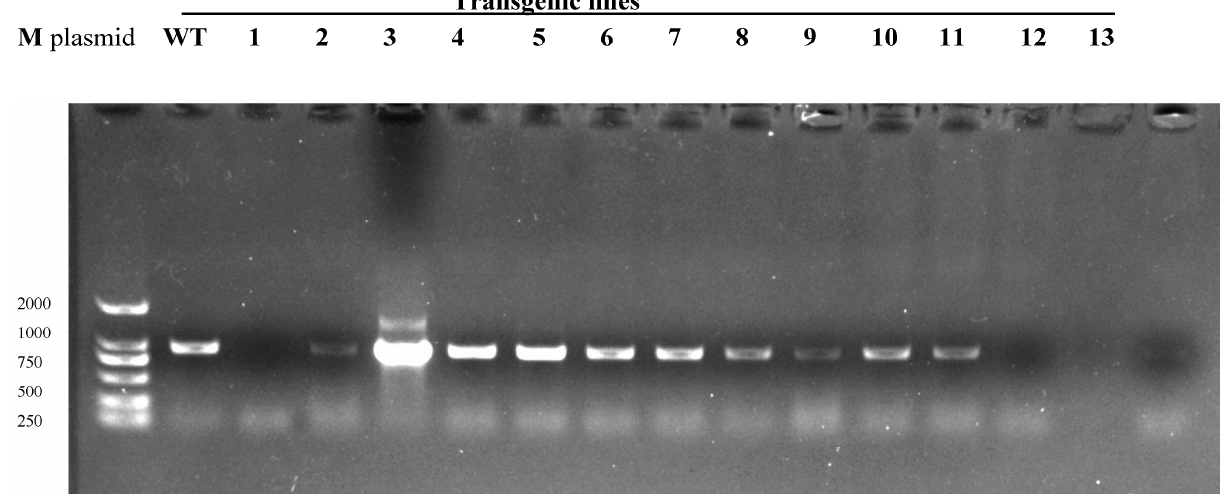
Figure 3. PCR detection of the ScD27.2 gene in transformed seedlings. Numbers 1 to 13 are the transformed plant sample. M, Marker; WT, Wild type.